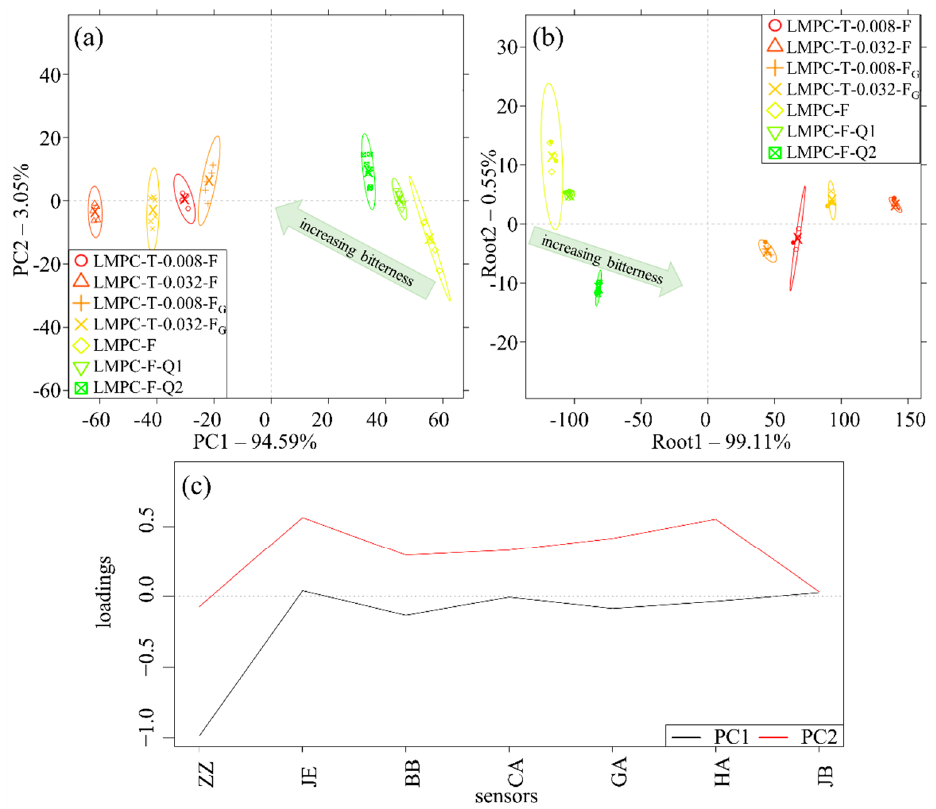
Figure 2. PCA score plot ( a ), LDA score plot ( b ) and PCA loading plots ( c ), which were developed based on the results of the E-tongue with aqueous solutions of LMPC-T-0.008-F, LMPC-T-0.032-F, LMPC-T-0.008-F G , LMPC-T-0.032-F G , LMPC-F, LMPC-F_Q1 and LMPC-F_Q2 (ellipses show the 95% confidence intervals, filled dots on the LDA figure represent the observations used in the cross- validation). LMPC: liquid milk protein concentrate, T: trypsin, F: fermentation with lactic acid bac-